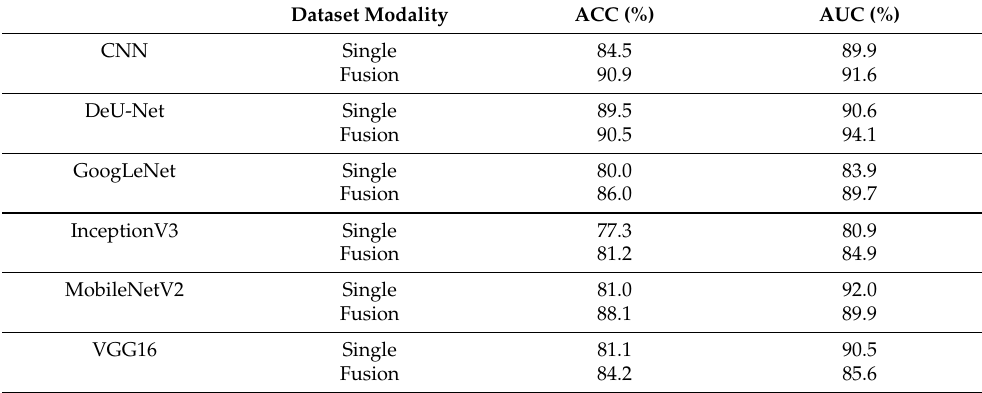
Table 8. Comparison between single modality images and fusion images implemented in training different deep learning